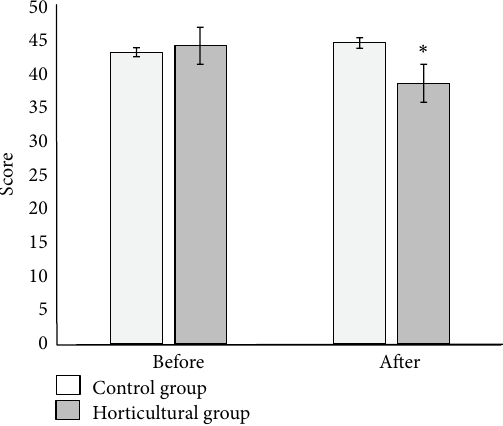
Figure 3: Comparison of pretest/posttest STAI data between the horticultural group and the control group. 푁 = 40 : mean ± SE. ∗ 푃 < 0.01 : determined using a paired t